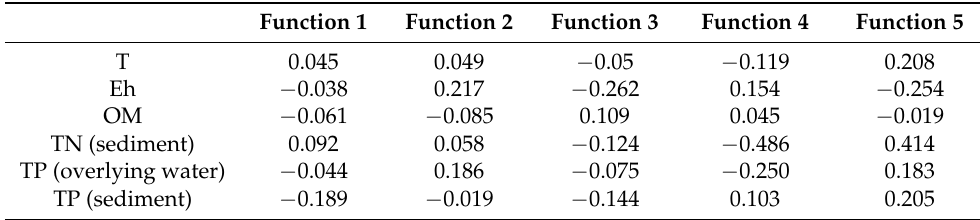
Table 1. Structure matrix for discriminant function of physicochemical parameters in overlying water and sediment of six rivers in Changchun City.